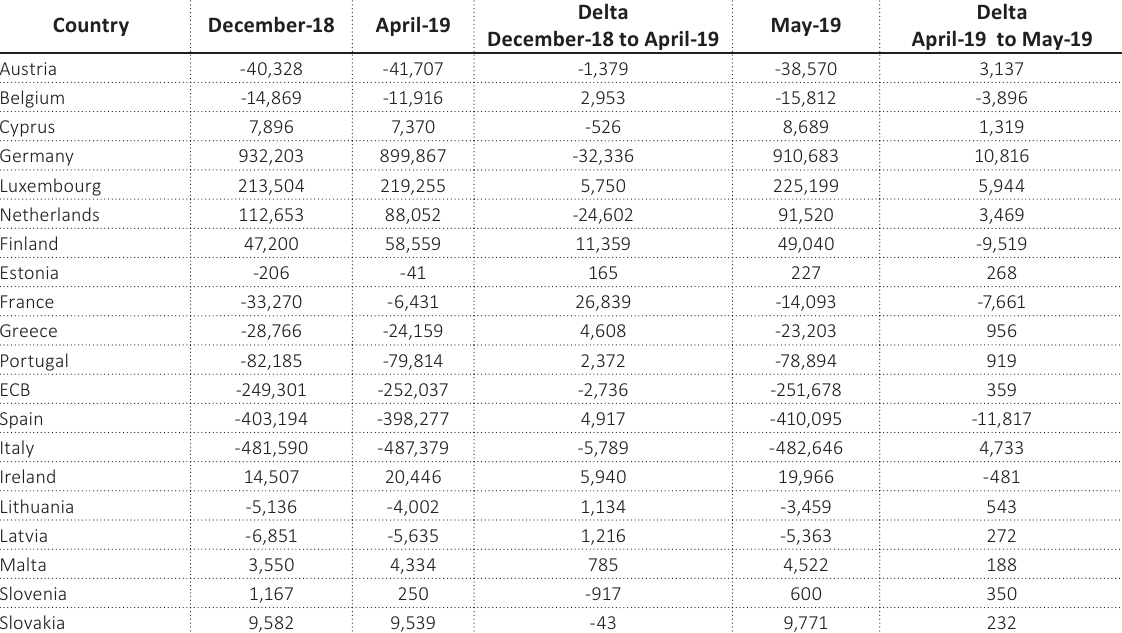
Table 2. T2 balances in million EUR between December 2018 and May 2019 Source: ECB’s Statistical Data Warehouse (monthly averages of daily data).